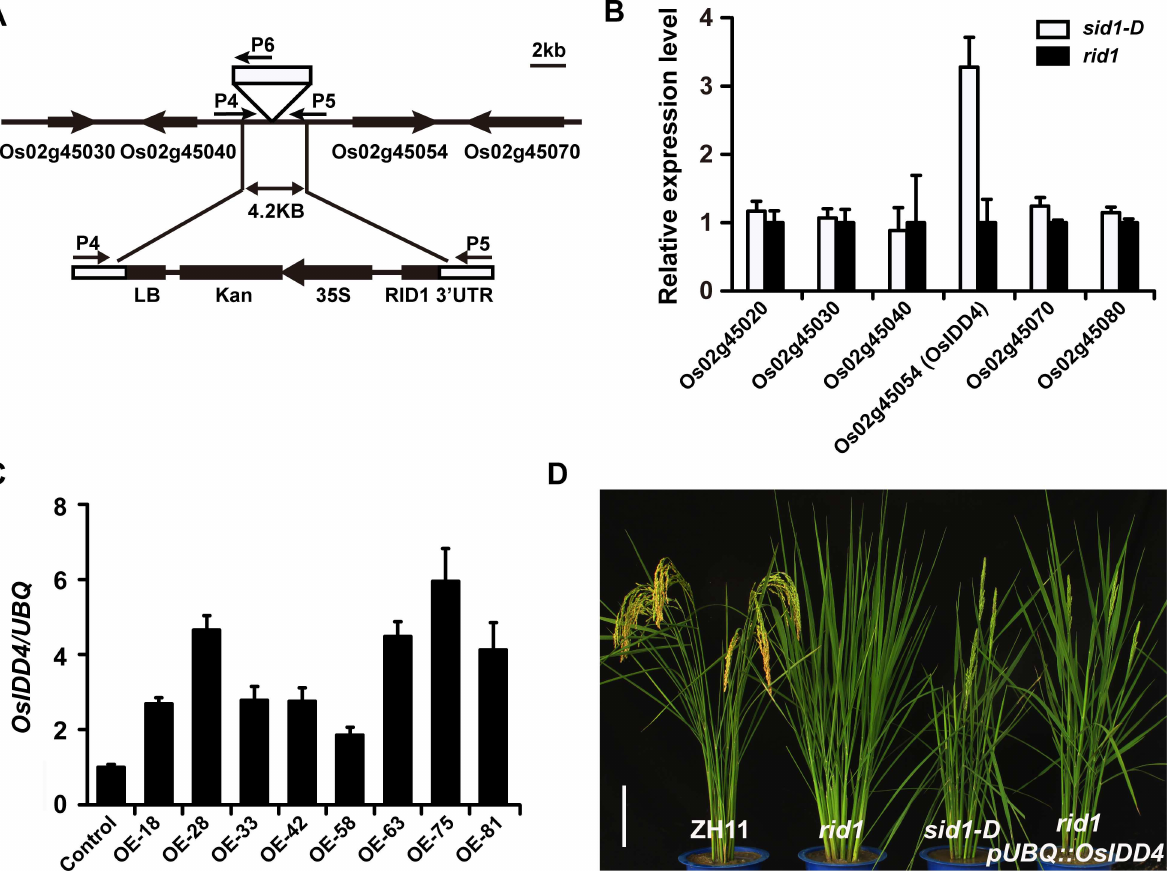
Fig 2. Molecular identification of SID1 . (A) Schematic of the genomicregionflankingT-DNA insertionsite and T-DNA insertionregionin sid1-D . Genes are shownas thick arrows, and intergenicregions are shown as lines at the top. T-DNA left border (LB), the selection marker Kanamycin driven by the CaMV 35S promoter, and a sequenceof 3’ untranslatedregionof RID1 are indicated.P4 to P6 primers indicatethe PCR primers used for genotyping the T-DNA in sid1-D . (B) Transcript analysesof the genes flankingthe T-DNA in sid1-D and rid1 plants. Note that the transcript of OsIDD4 (LOC_Os02g45054) is highly elevatedin sid1-D . Expression data relative to control were normalized to that of Ubiquitin ( UBQ ). Each bar represents the mean ± SEM. (C) Expression level of independent T0 transgenic floweringlines generated by transforming homozygouscallus of rid1 with pUBQ :: OsIDD4 . Control, transgene-negativecontrol plant. (D) Phenotypes of wild-type(ZH11), rid1 , sid1-D , and rid1 pUBQ :: OsIDD4 at headingstage. Scale bar, 15 cm.